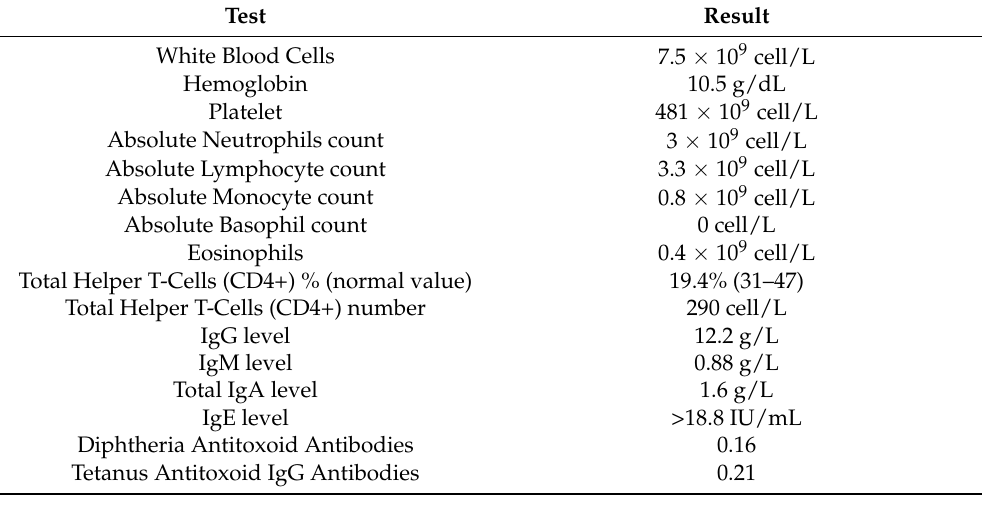
Table 1. Laboratory Investigations.